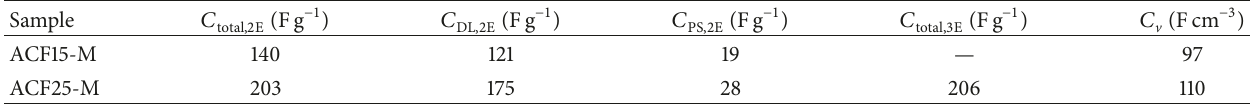
Table 2: Results from electrochemical